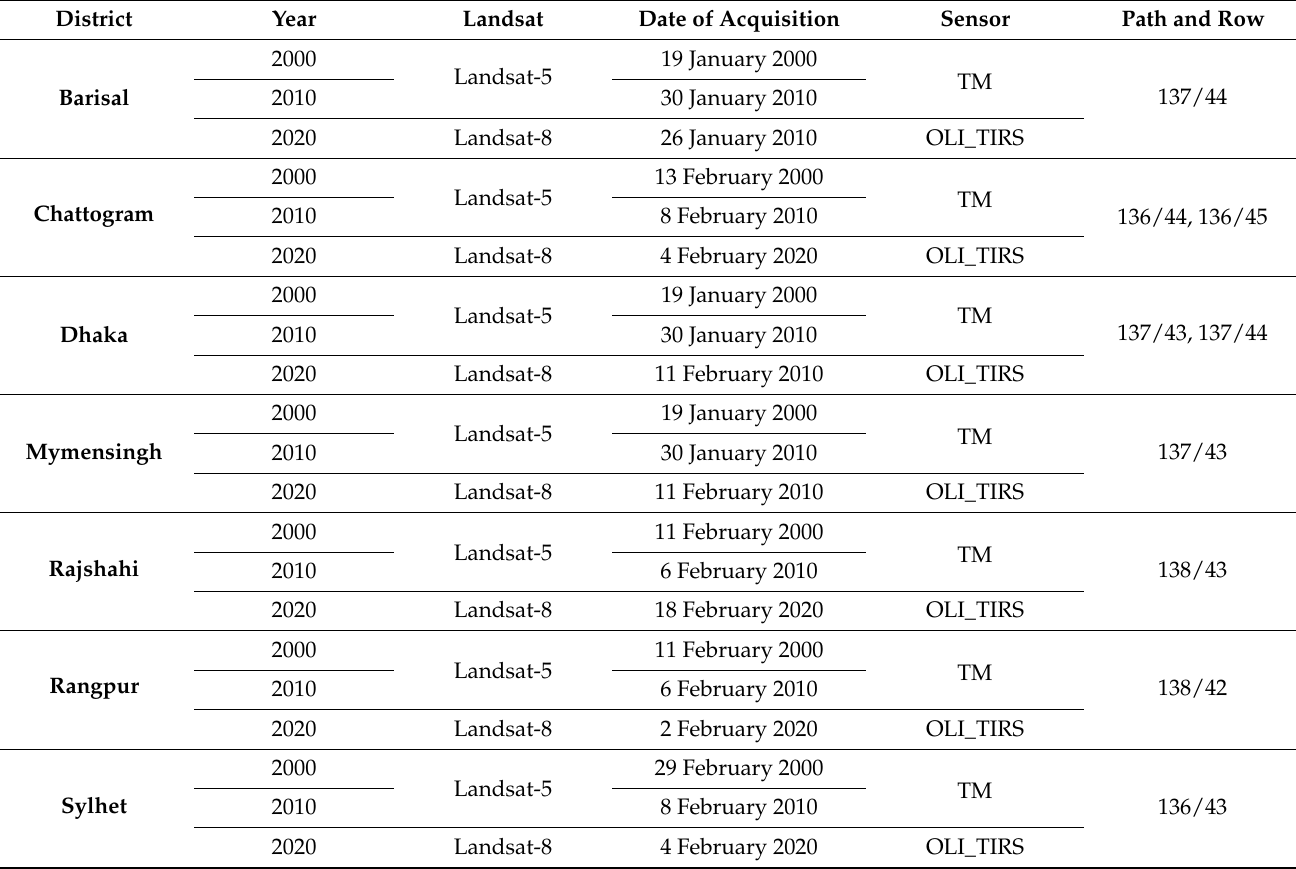
Table 2. Landsat image details for this